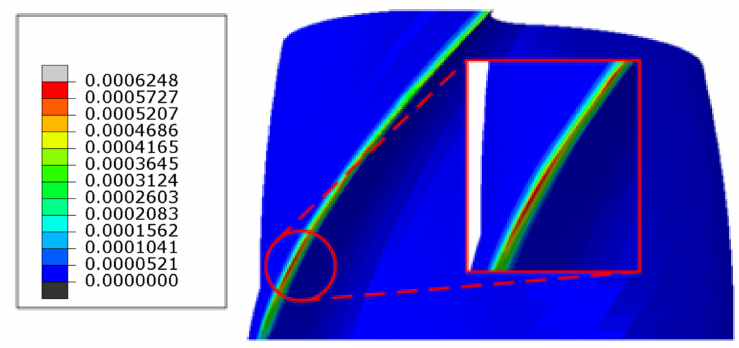
Figure 13. Cloud diagram of tool abrasion loss (unit: mm / 10 s).